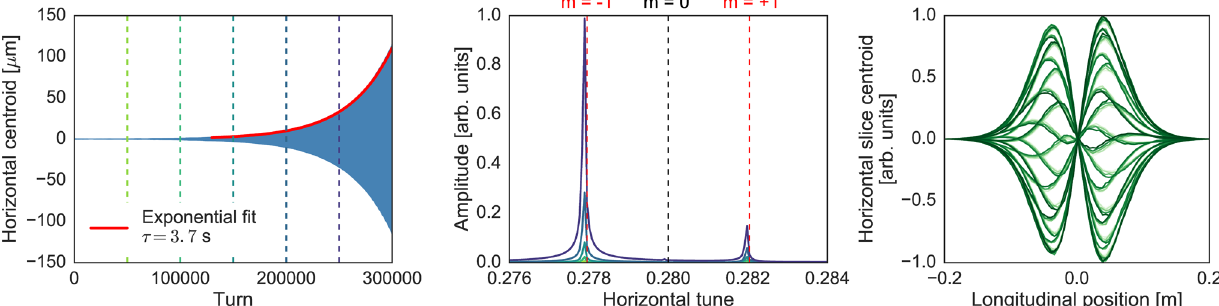
FIG. 8. Left: Horizontal bunch centroid evolution over time with an exponential fit of the rise time (red). Middle: Frequency spectra of the bunch centroid at different times during the simulation (see dashed lines in the first plot). The most unstable mode is an azimuthal mode m ¼ − 1 in agreement with the experiments. Right: Horizontal slice centroid vs. longitudinal position for 80 consecutive turns. The head-tail motion is characterized by one node in the center of the bunch.